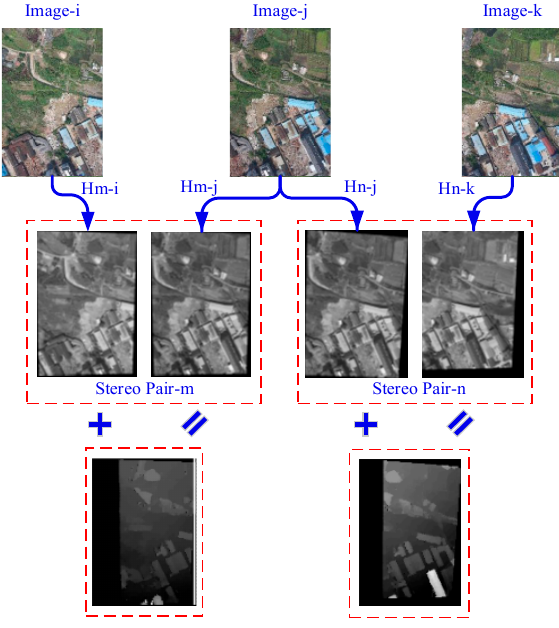
Figure 5. The geometric correspondence relationship across multi-view images based on a graph network. First, a pixel on base image can be transformed to left epipolar image by homographic matrix (cid:1834) (cid:3039) . Then, the correspondence on the right epipolar image can be calculated using the disparity image of the base image. Finally, a pixel on a matched image can be obtained by multiplying inverted homographic matrix (cid:1834) (cid:3045) .